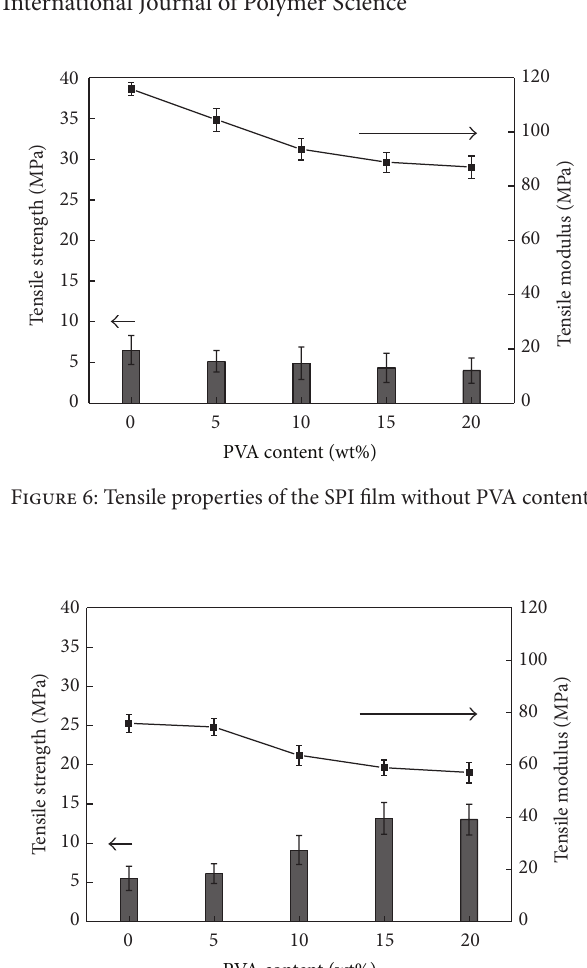
Figure 7: Tensile properties of the SPI/glycerol film with PVA content.